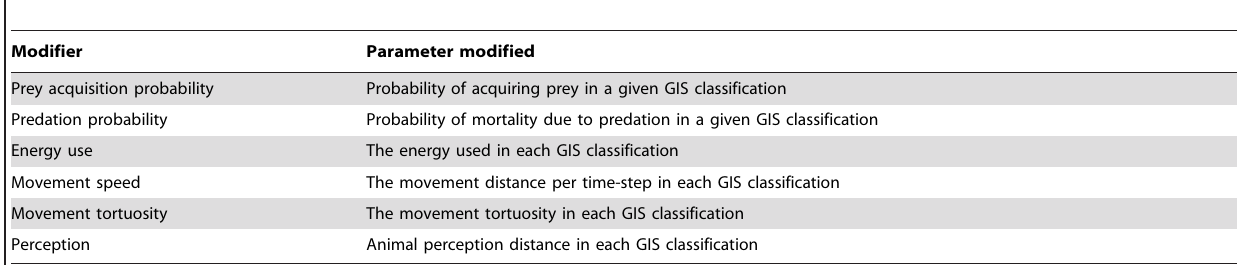
Table 3. Modifiers of animal behavior employed in SEARCH which allow the user to modify habitat values by multiplying them by a real number to reflect variation caused by gender, activity mode, vigilance mode, time of day, and